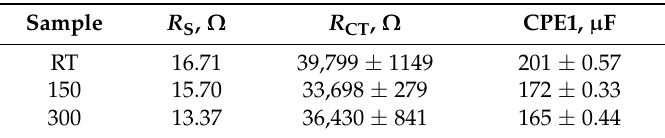
Table 2. Electrochemical Impedance spectroscopy data from measurement taken at 0 V vs. Ag/AgCl under 1 sun